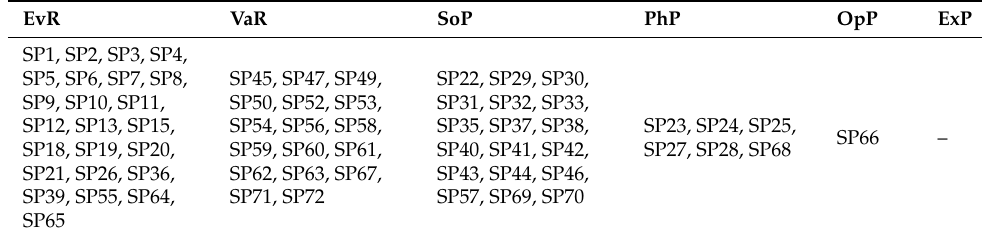
Table 13. Selected papers and validation of the proposals.